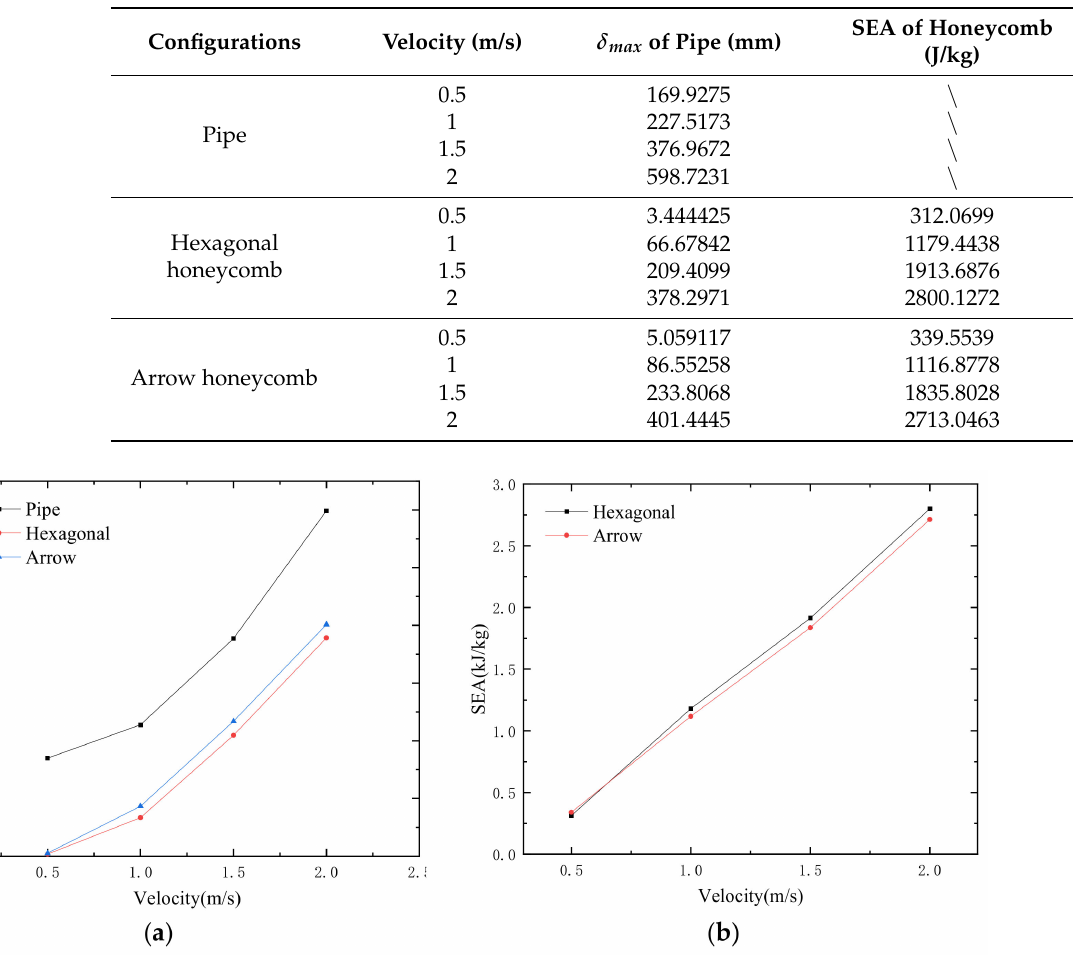
Table 6. Crashworthiness indices of three structures at different speeds in the bulb bow of ship collision.